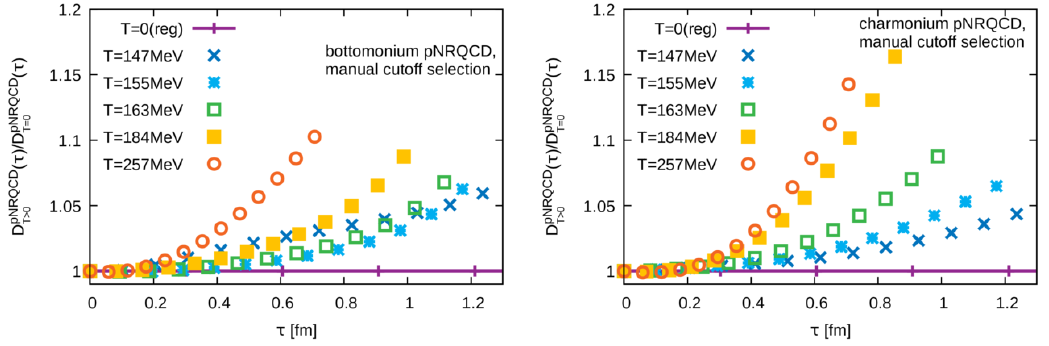
Figure 18 . Ratio of the in-medium to the zero temperature correlator from a tree-level pNRQCD computation based on a recent determination of the complex heavy quark potential from the lattice. These ratios are taken as a qualitative guide for interpreting the lattice NRQCD results. Note that for bottomonium (left) the early melting of the higher excited states induces a non-monotonicity in the ratio similar to that observed in the NRQCD correlator and which is absent for charmonium